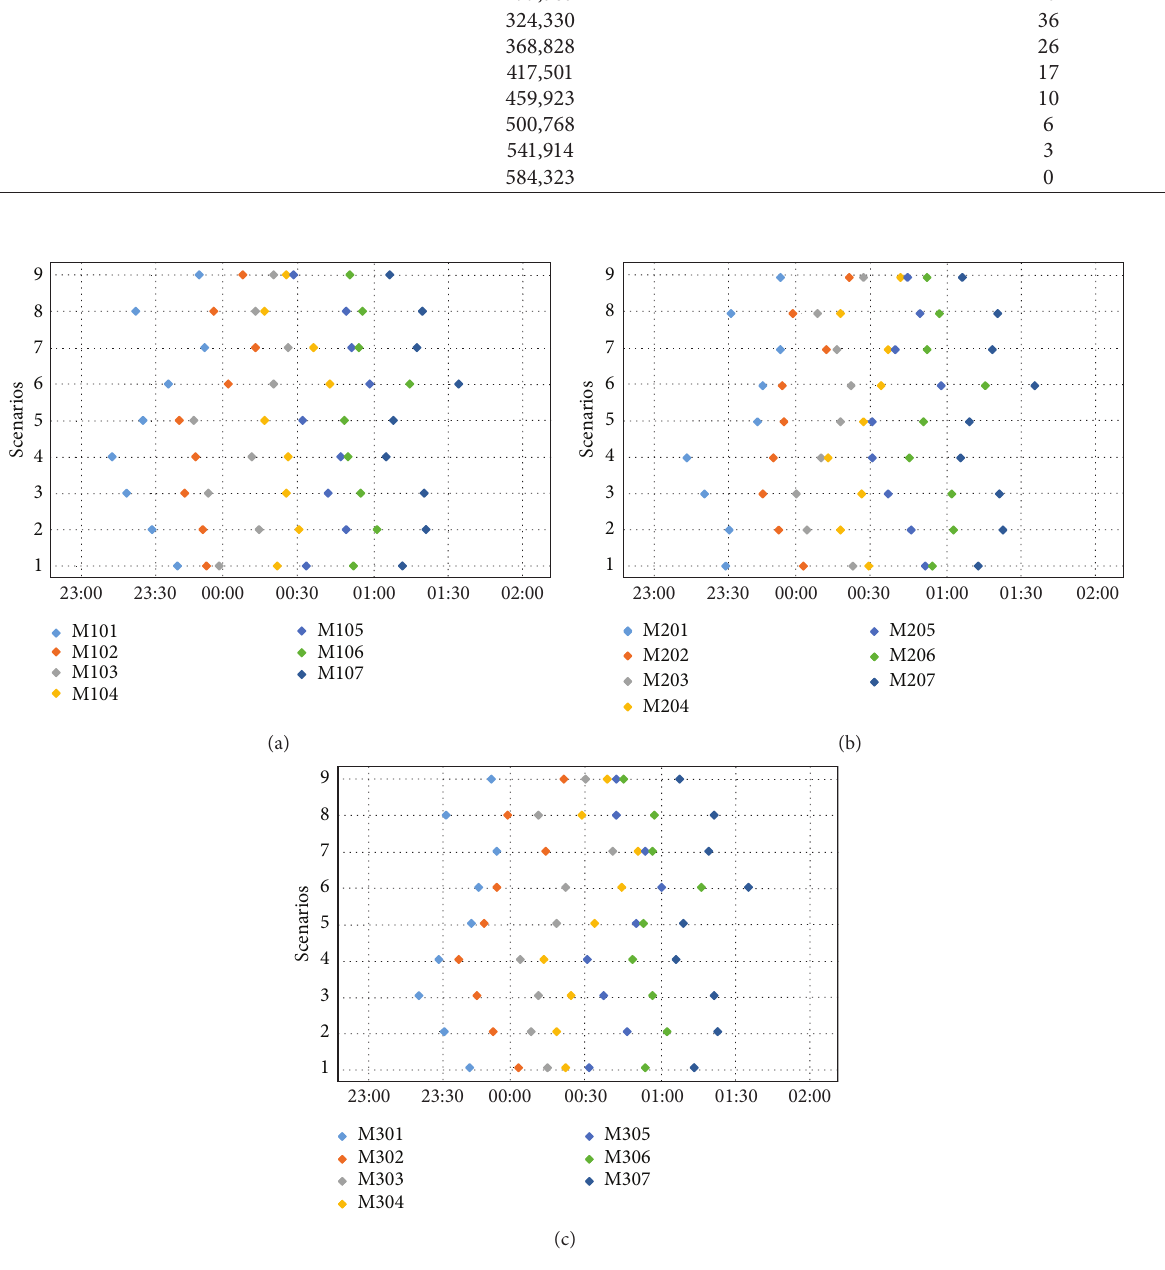
Figure 9: Departure time of each extra metro train service from BSRS in the three operation directions. (a) Operation direction 1. (b) Operation direction 2. (c) Operation direction 3.